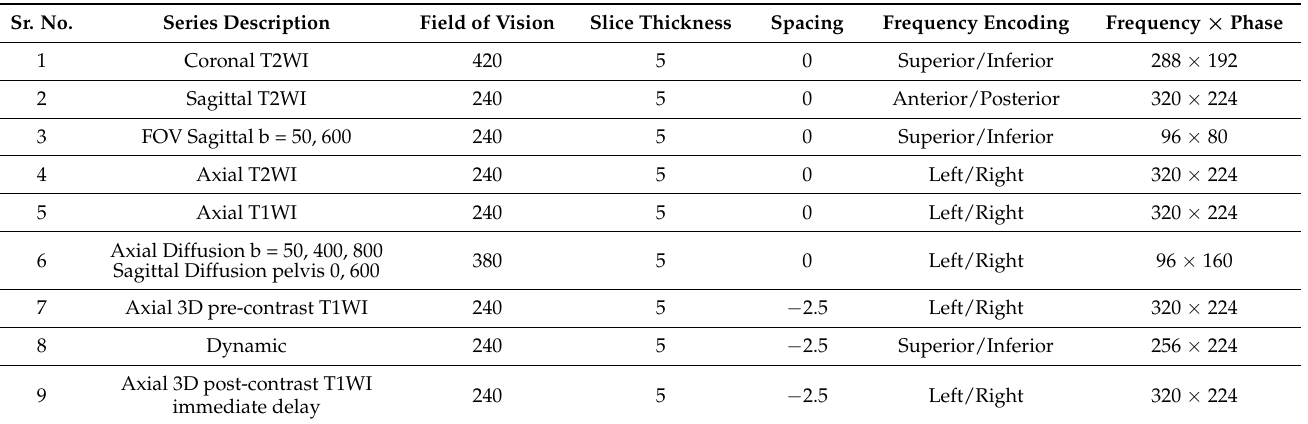
Table 1. 3T MRI pelvis protocol sequences.